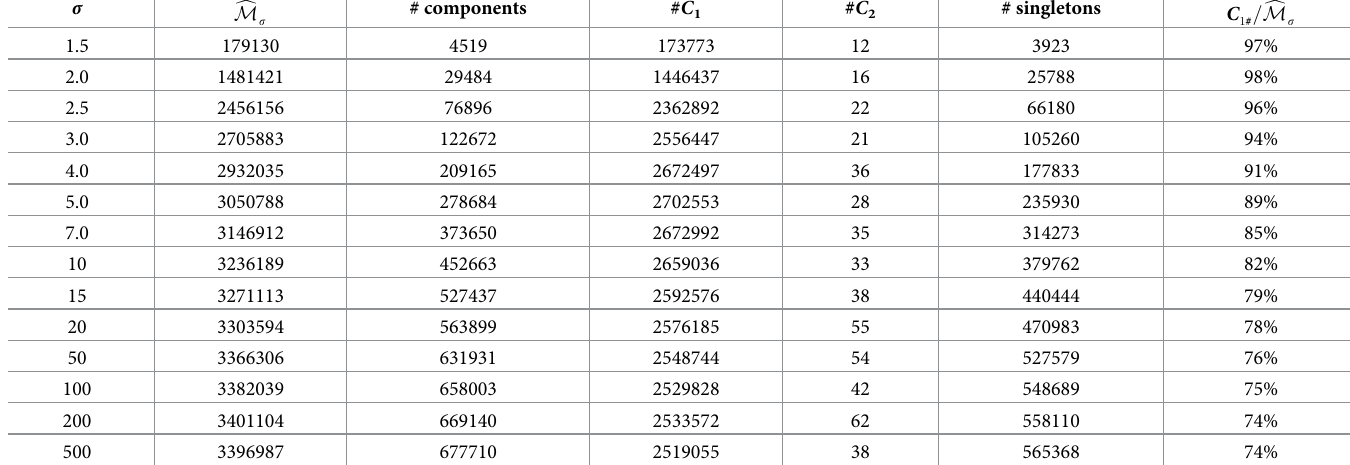
Table 1. Connectivity of the bistable region. Details of the initial connectivity graphs for the indicated values of σ in column 1. Column 2 gives the number of bistable points in the set used to construct the graph; column 3 gives the number of connected components in the resulting connectivity graph; columns 4 and 5 give the sizes of the largest and second-largest components of the graph, respectively; column 6 gives the number of singleton components; and column 7 gives the size of the largest com- ponent as a percentage of the number of bistable points in the sample. The numbers show that the connectivity graphs consist of one large component and many very small components, suggesting that the bistable region is connected for all examined values of σ . Details of the connectivity graphs obtained through refinement with addi- tional sampling (Results, Materials and methods) are given in S1 Appendix.